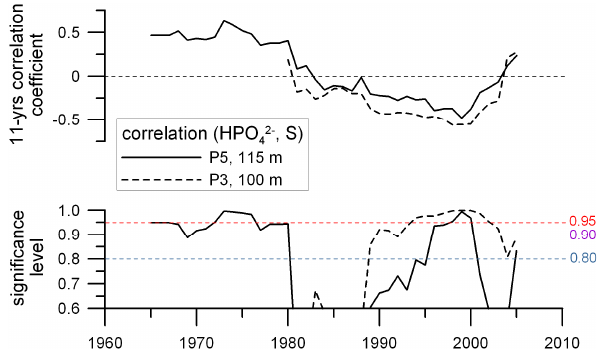
Fig. 10. Time series of 11-year running linear correlation coeffi- Figure 10. Time series of 11-years running linear correlation coefficients between salinity and cients between salinity and orthophosphates, and associated signif- orthophosphates, and associated significance levels estimated for deep layers of stations P3 icance levels estimated for deep layers of stations P3 and and P5.